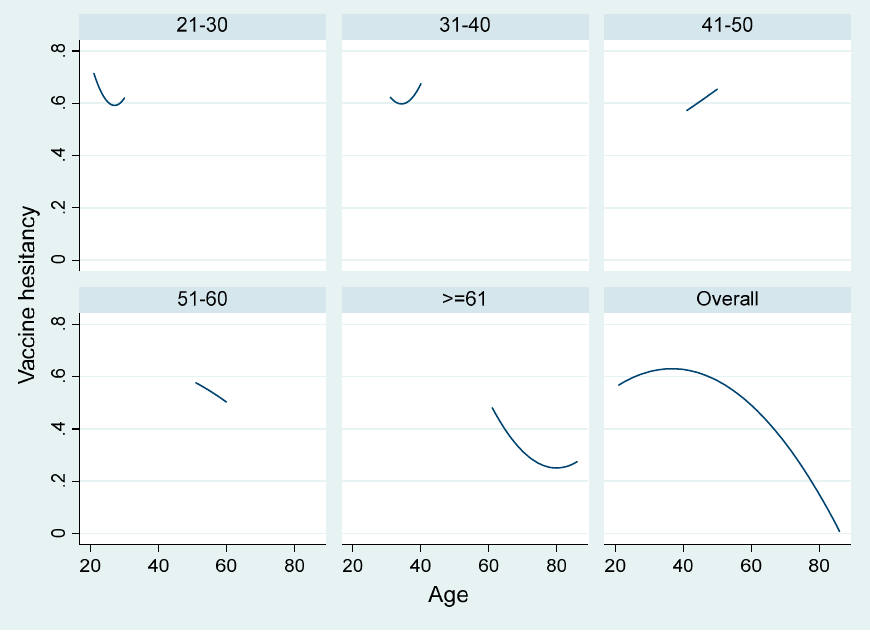
Figure 2. Fitted values of vaccine hesitancy variable by age group.